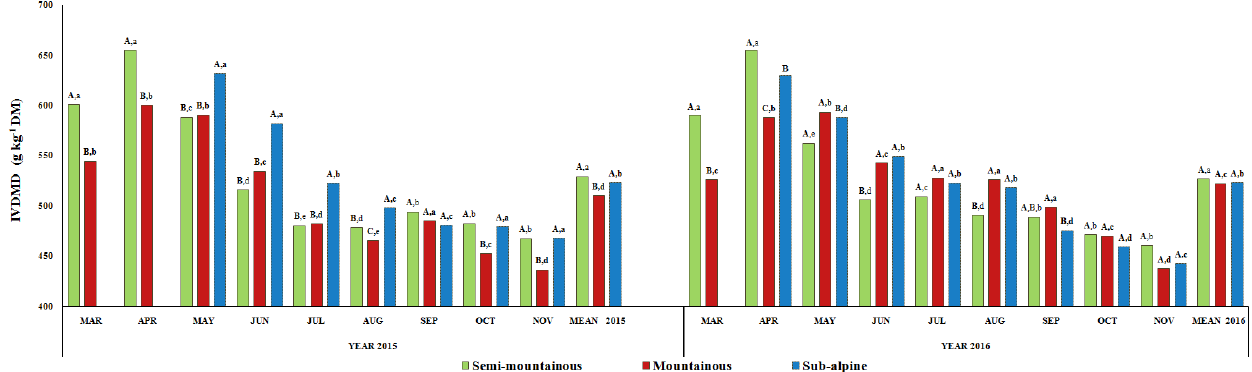
Figure 4. Interannual and monthly variation of herbage in vitro dry matter digestibility (IVDMD; gkg − 1 DM) of the semi-mountainous, mountainous and sub-alpine grasslands in the Florina Prefecture, northern Greece. Means of the three grasslands between the 2-year exper- imental period followed by different letters (a–d) along the corresponding bar differ at P < 0 . 05. Means of the three grasslands in the same year of the experimental period followed by different capital letters (A–C) along the corresponding bar differ at P < 0 .